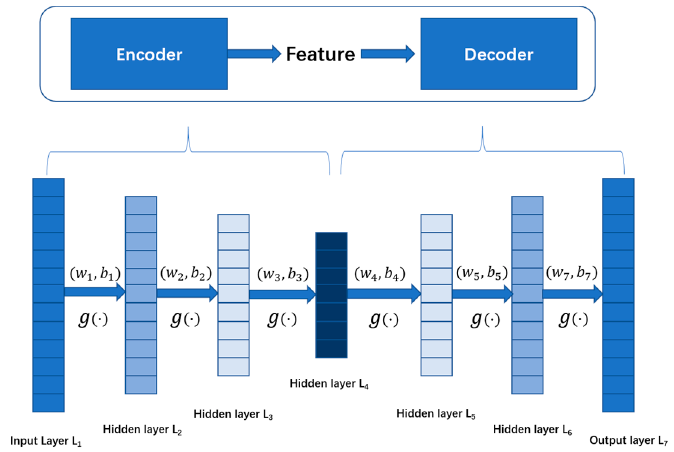
Figure 3. Auto-encoder structure.